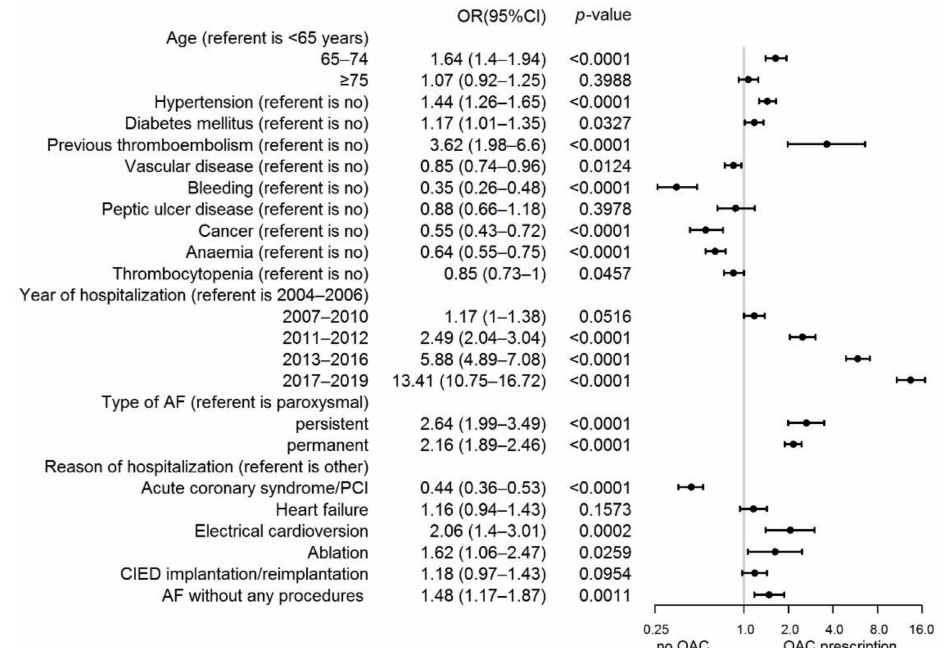
Figure 4. Factors associated with the oral anticoagulants prescriptions for stroke prevention in patients with AF: multivariable logistic regression models. Abbreviations: AF, atrial fibrillation; CIED, cardiac implantable electronic device; OAC, oral anticoagulant; OR, odds ratio; and PCI, percutaneous coronary